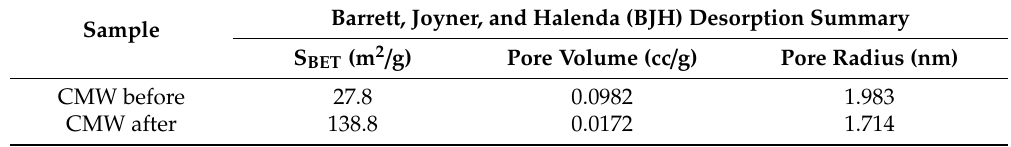
Table 2. Surface behavior comparison before and after the treatment of carbonated mud waste